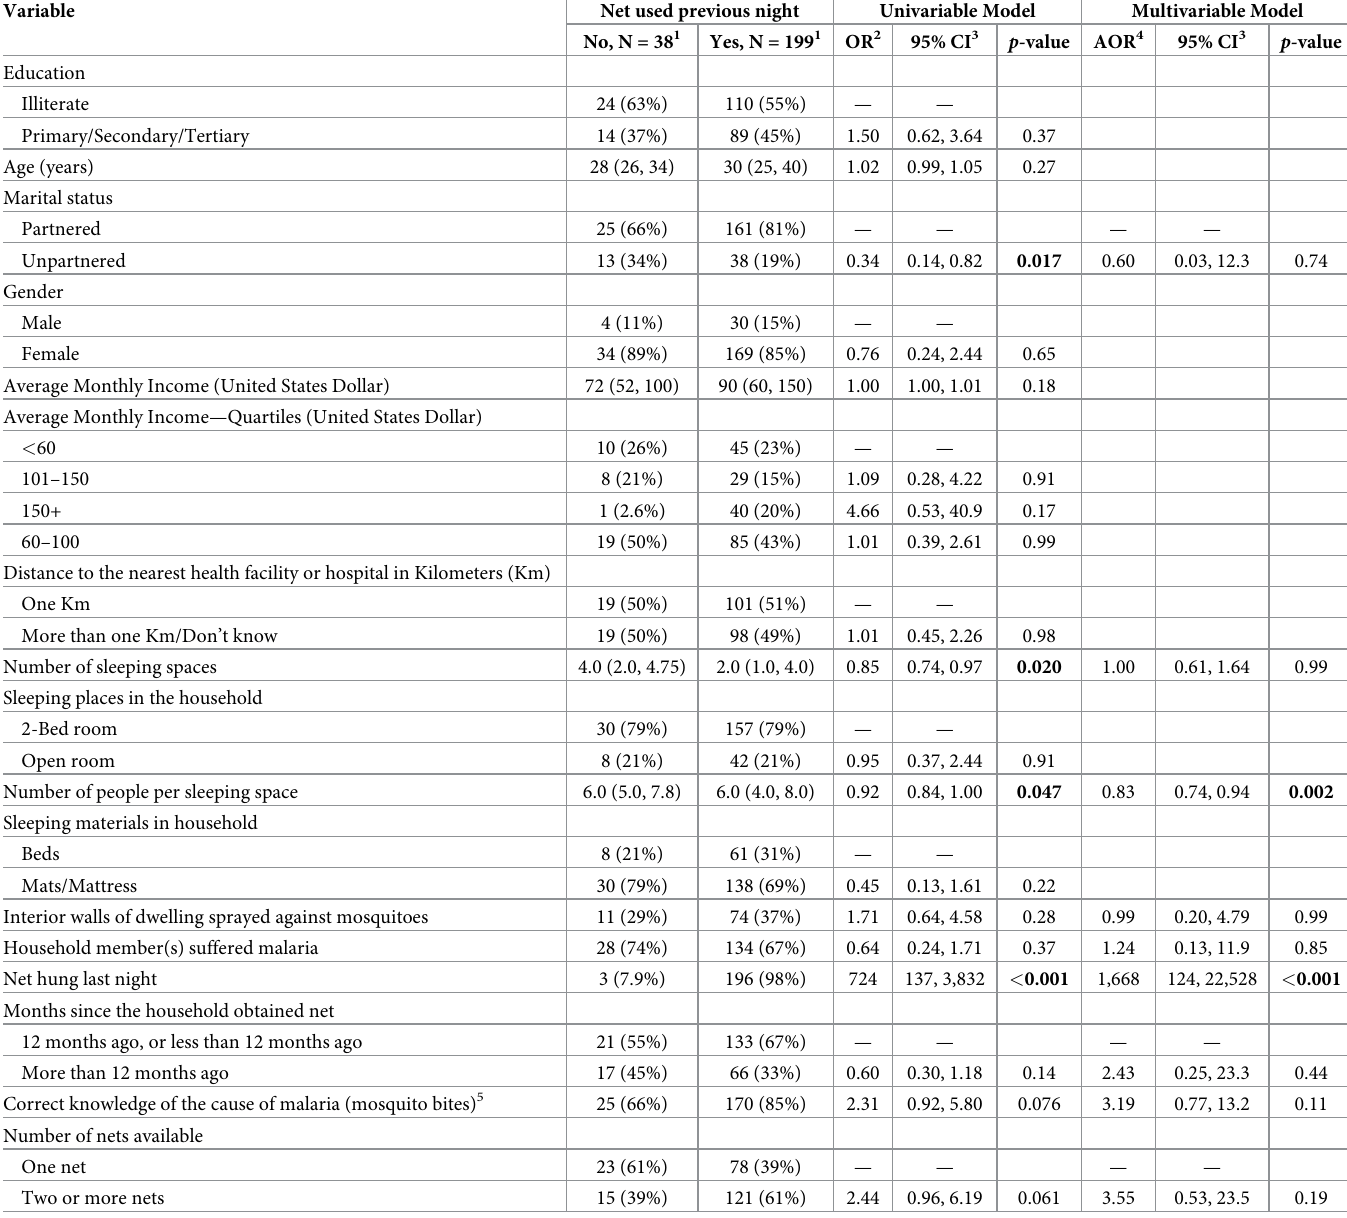
Table 7. Factors associated with reported utilization of LLIN the night prior to the survey in Mogadishu–Somalia, based on a generalized estimating equation model (n =